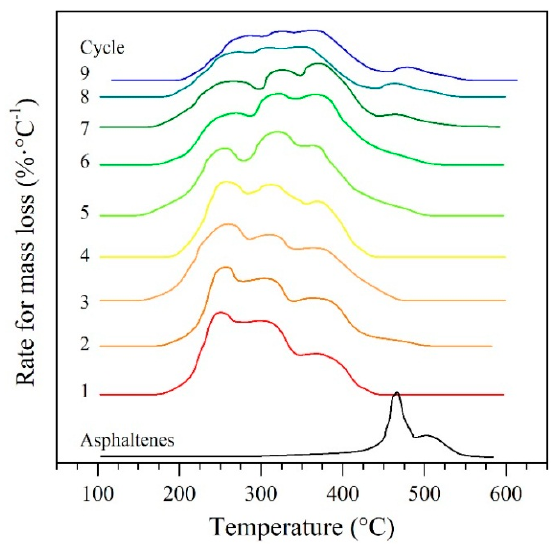
Figure 4. The rate for mass loss as a function of the temperature for catalytic steam decomposition of n -C 7 asphaltenes in the absence and presence of CeNi0.89Pd1.1 nanoparticles for several catalyst regeneration cycles of adsorption and subsequent catalytic steam gasification. Nitrogen flow rate = 100 mL · min − 1 , H 2 O (g) flow rate = 6.30 mL · min − 1 , heating rate = 20 ◦ C · min − 1 , and asphaltene load of 0.02 mg · m − 2 .